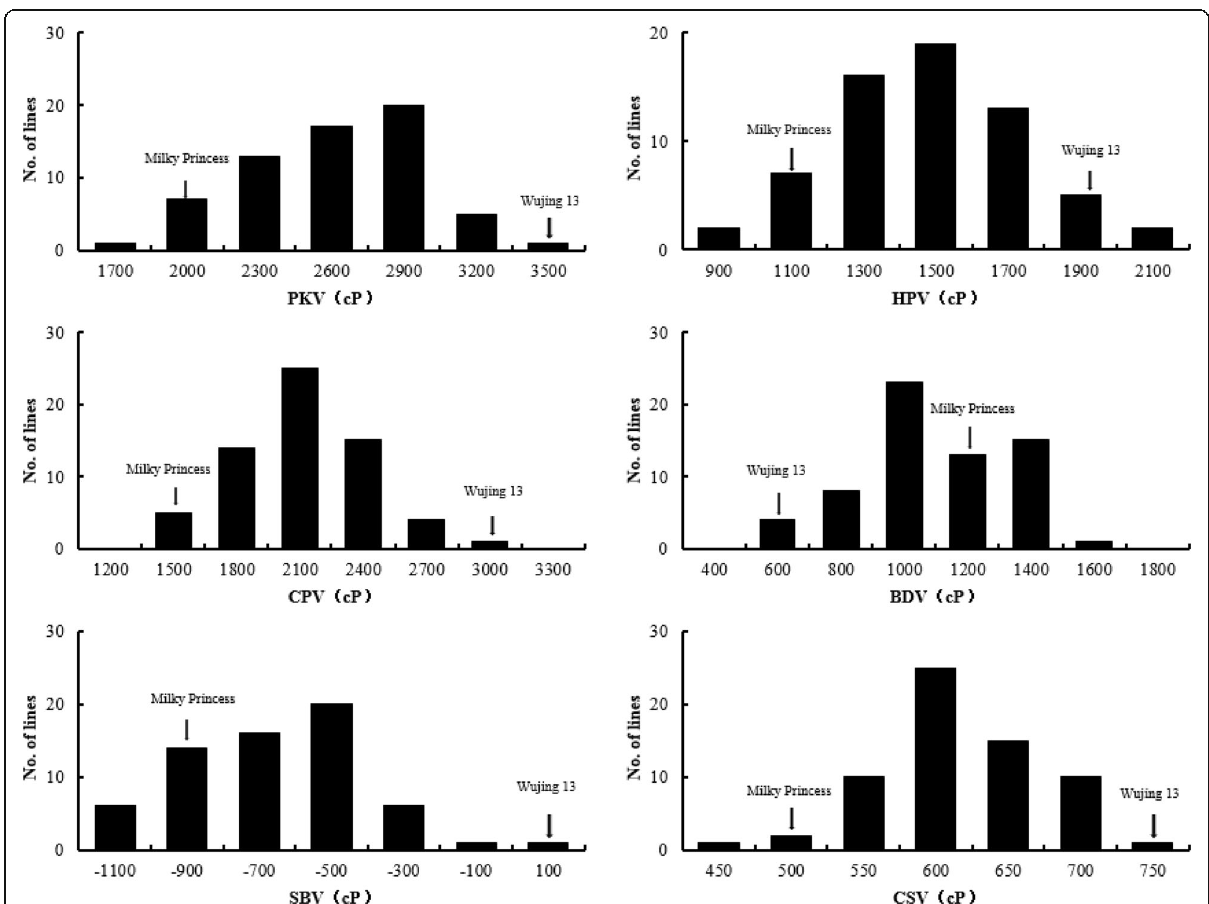
Fig. 5 Frequency distribution of the RVA profile characteristics in 64 semi waxy